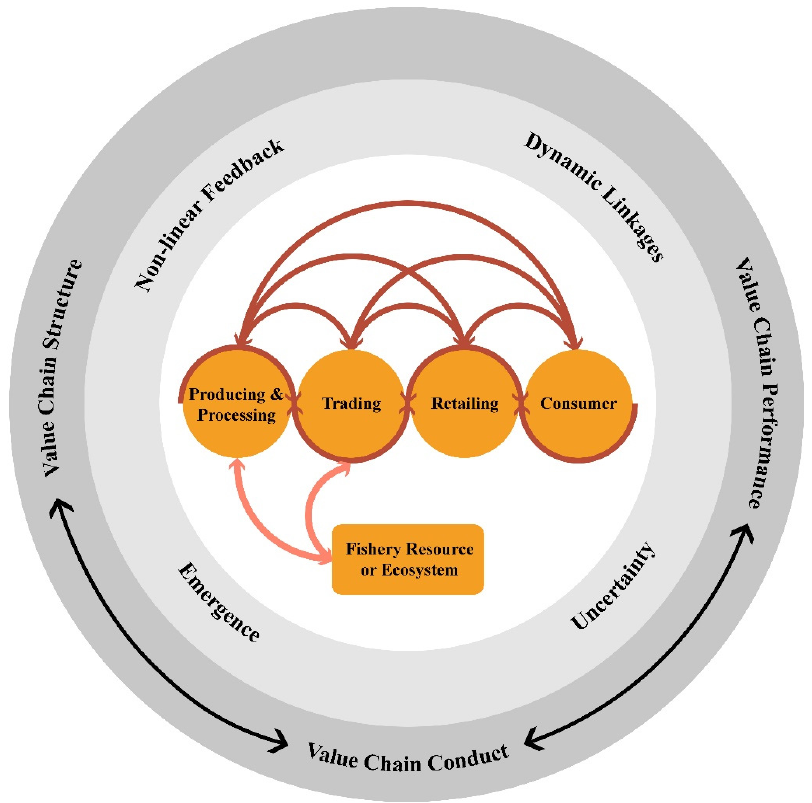
Figure 1. Social-ecological systems oriented dried fish value chain (SESDFVC) conceptual framework. Source: Pradhan et al., 2022: p.8 [6].